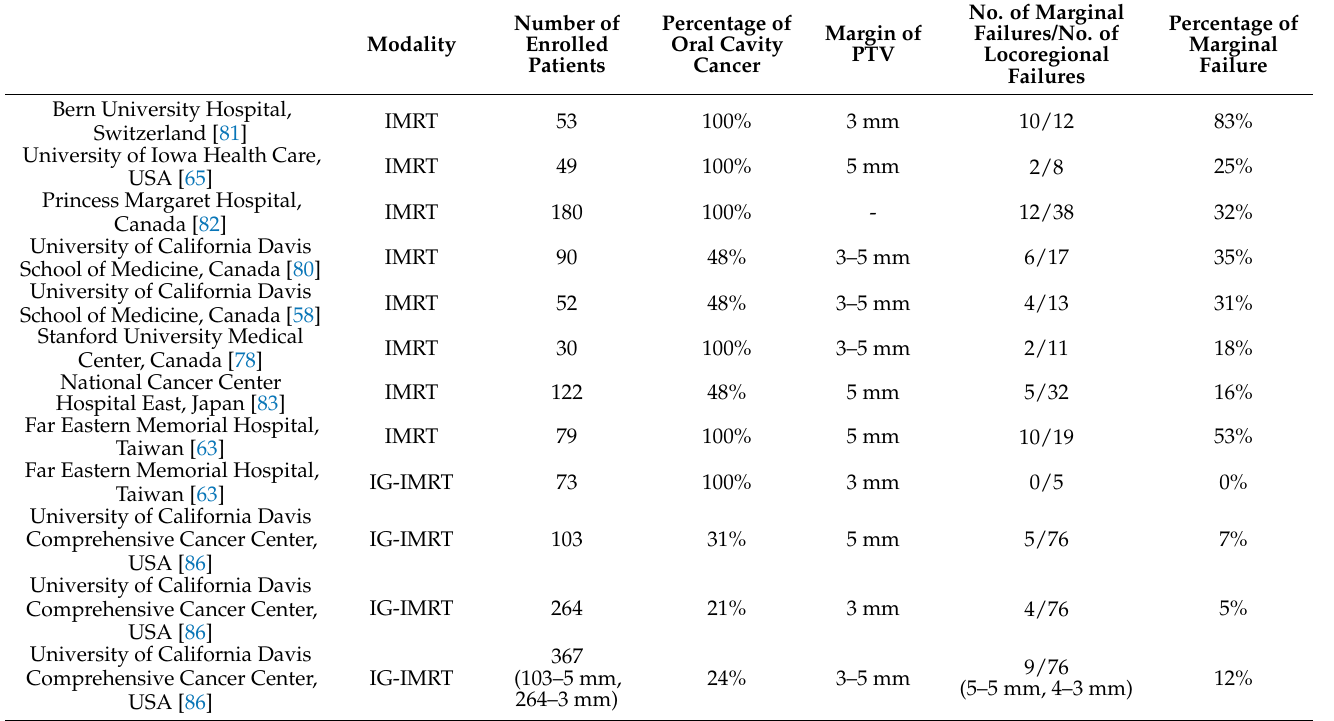
Table 3. Marginal failure rate with intensity-modulated radiotherapy and image-guided intensity- modulated